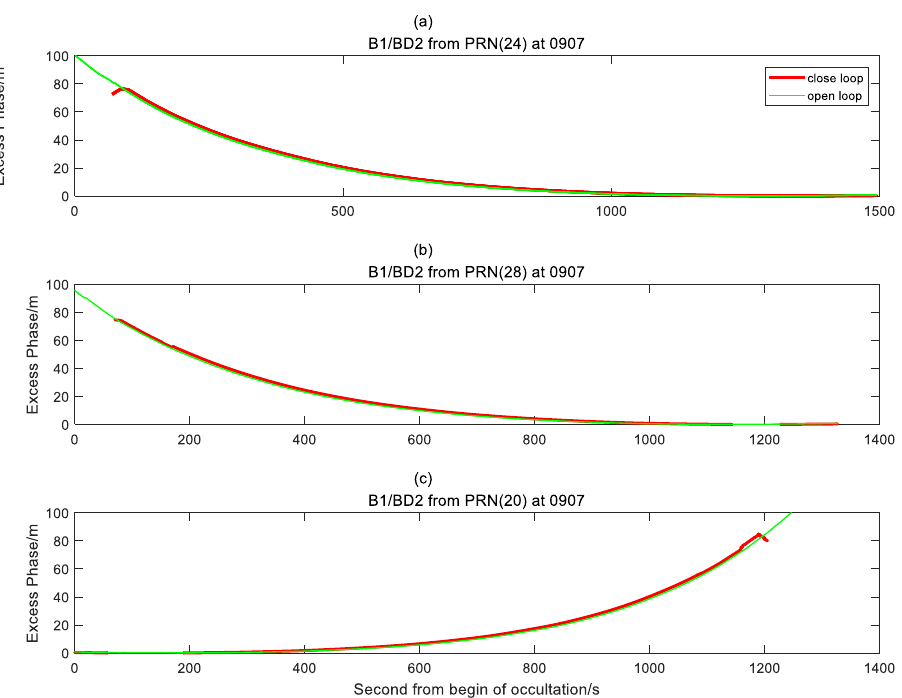
Figure 6. Excess phases retrieved from observations of B1 / BD in OL / closed-loop tracking mode. Red / green lines represent the phases in closed-loop / OL tracking mode, respectively. ( a ) C24 / BD occultation; ( b ) C28 / BD occultation; and ( c ) C20 / BD occultation.